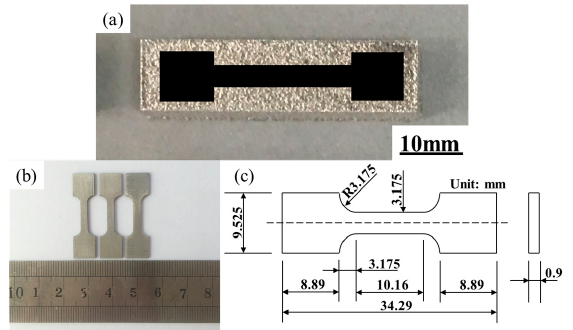
Table 2. Single-track experiments of process